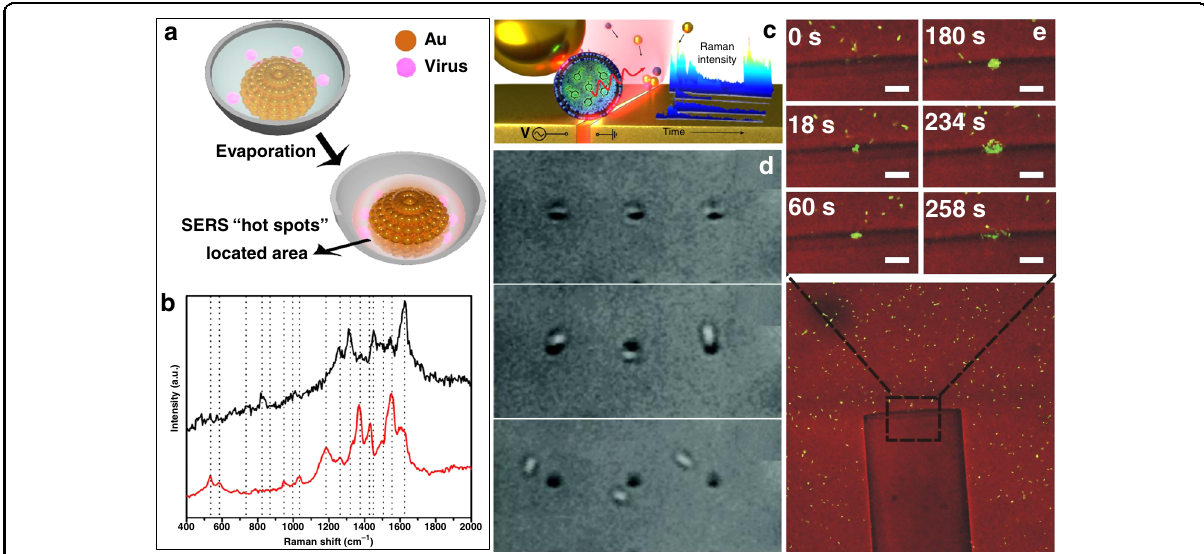
Fig. 14 Plasmonic tweezers platform for trapping of large biological particles. a Demonstration of the Ag- fi lm-covered Au PCIB structure enabling delivery of analyte molecules (particularly large organisms) during solvent evaporation into a Au cluster/Ag bowl interface area. b SERS spectra of poliovirus. c Integrated nanogap plasmonic sensing platform that combines subvolt dielectrophoresis trapping, gold nanoparticles (AuNPs), and a lineated illumination scheme for real-time, surface-enhanced Raman spectroscopy (SERS) imaging of biological nanovesicles. d Successive frames showing simultaneous trapping of E. coli bacteria. The incident laser (800 nm) was switched off just before recording the middle frame. e Side-view time-sequence images of trapping of E. coli cells by the gold-coated fi bre tip. a , b Adapted with permission from ref. 275 , copyright 2018 American Chemical Society. c Adapted with permission from ref. 271 , Copyright 2018 American Chemical Society. d Adapted with